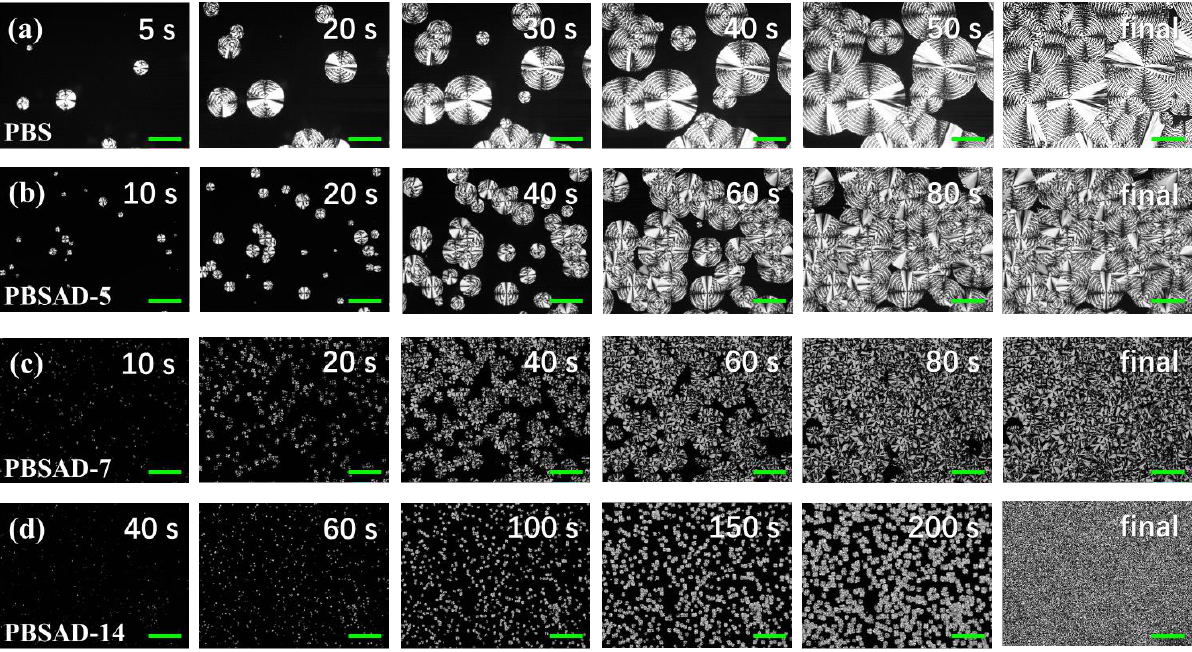
Figure 6. POM images of polyester spherulites grown at 80 °C. ( a ) PBS, ( b ) PBSAD-5, ( c ) PBSAD-7, and ( d ) PBSAD-14. All scale bars are 100 μm in length. The melt was quickly transferred from melt to 80 °C within 1 s.